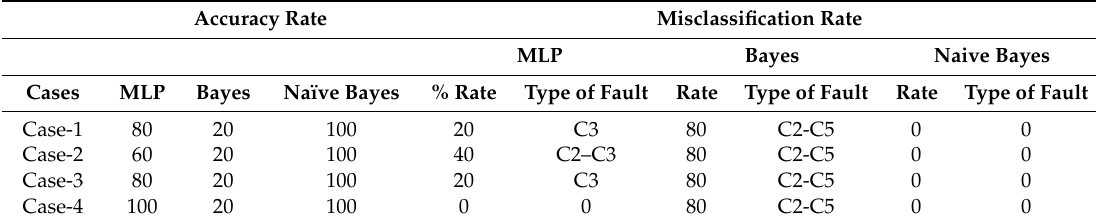
Table 8. Classifiers’ Accuracy and Misclassification